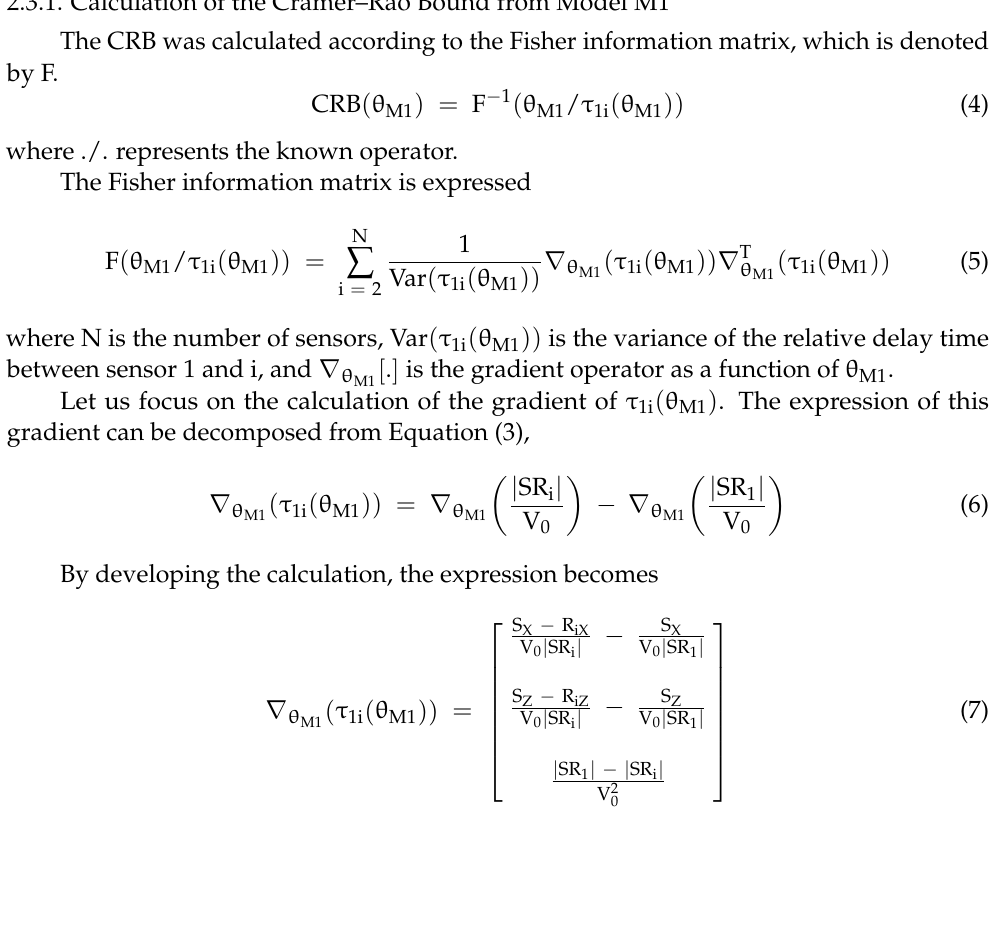
Figure 3. Comparison of travel time estimate of Model M1 (dashed blue line) with the full P-wavefield propagation model using finite differences.